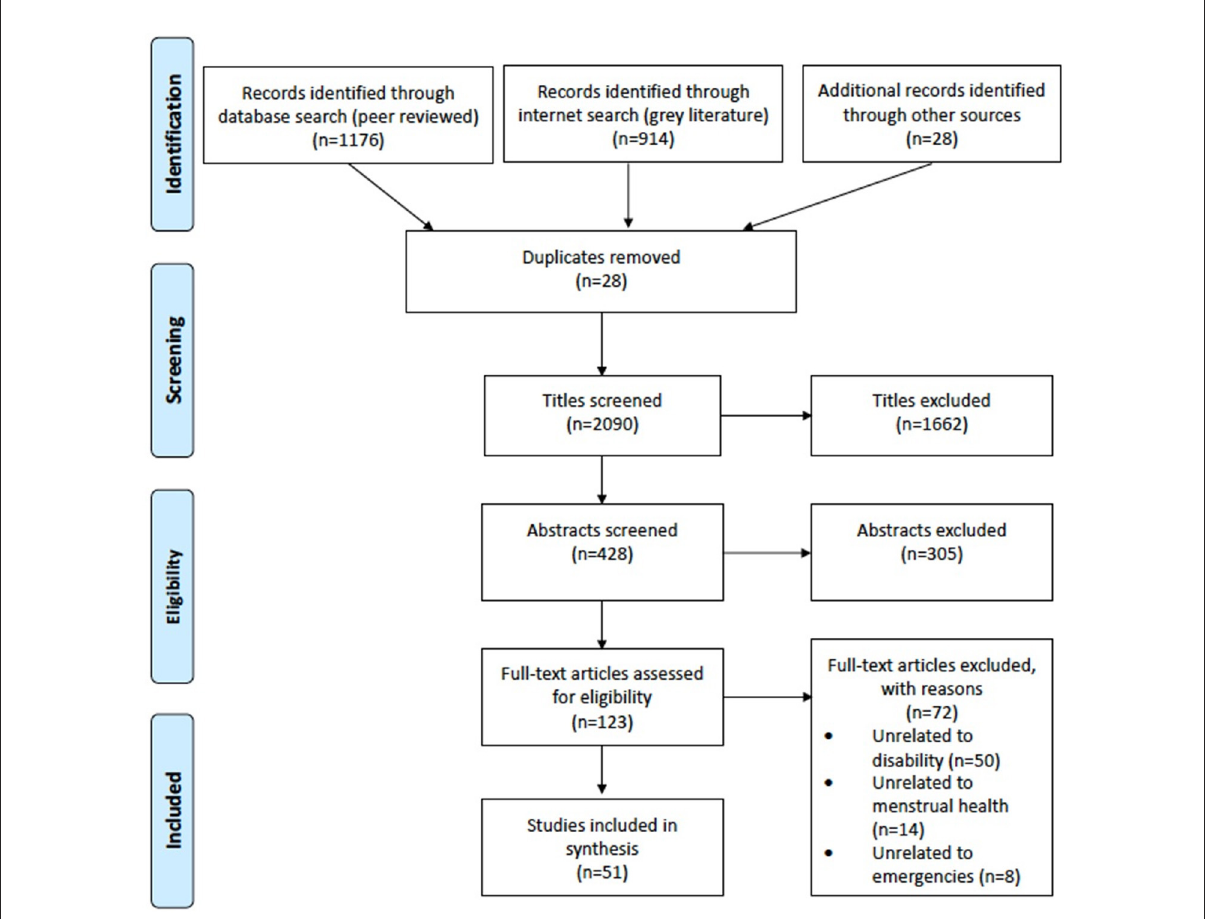
FIGURE1 Flow chart showing screening and identification of papers for data